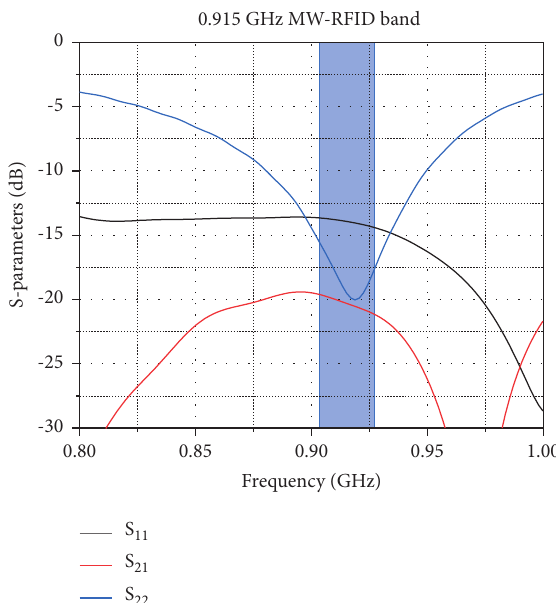
Figure 4: S-parameters of the feeding network for FCC UHF-RFID band.